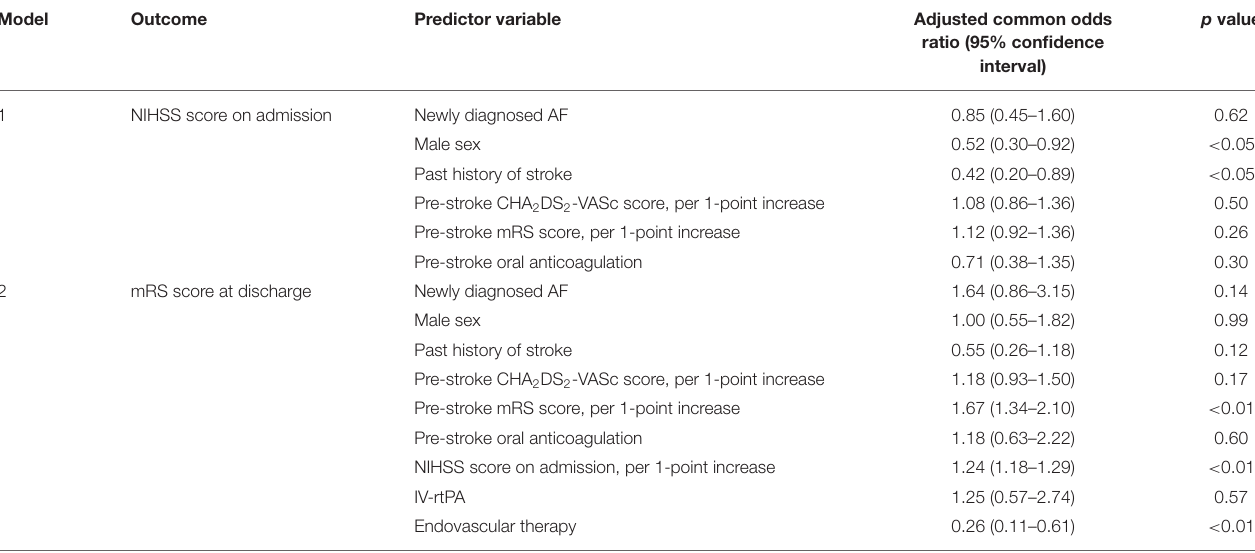
TABLE 2 | Adjusted common odds ratios for outcomes.